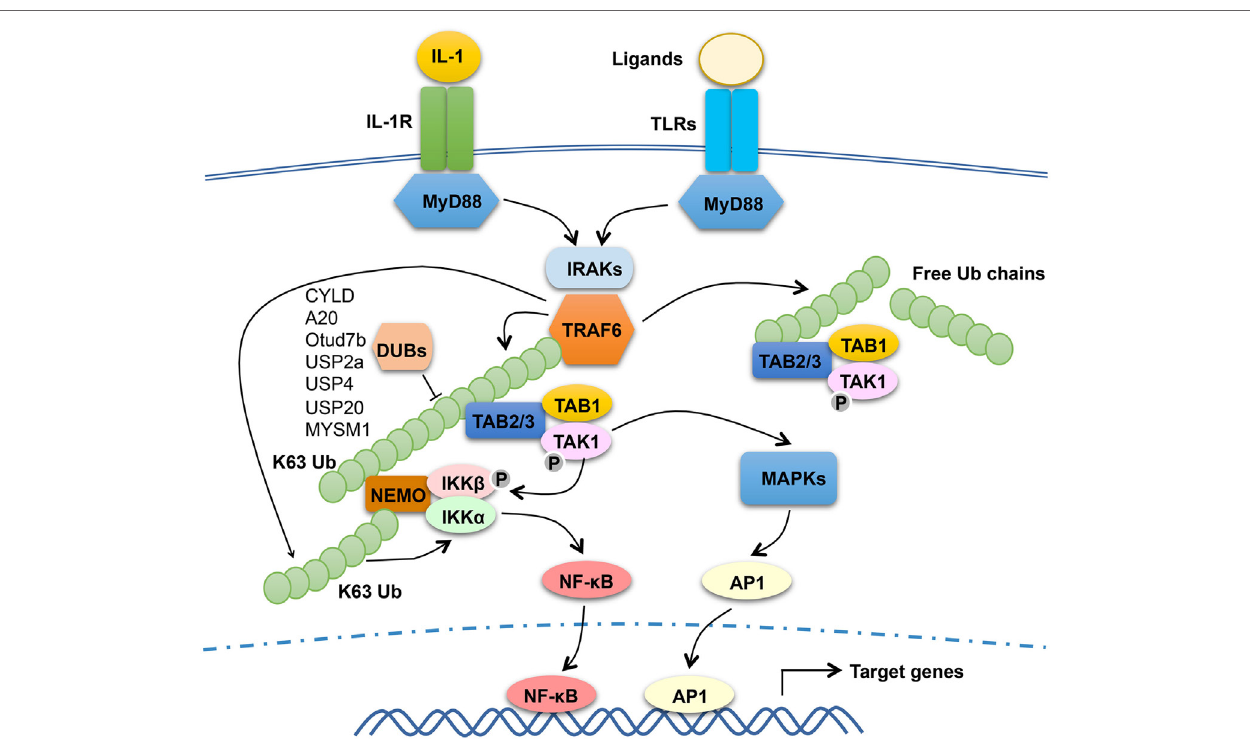
FigURe 1 | The function and regulation of tumor necrosis factor receptor-associated factor (TRAF)6 in MyD88 signaling pathway. Upon stimulation with IL-1 or toll-like receptor (TLR) ligands, MyD88 recruits IL-1R-associated kinases (IRAKs) (including IRAK1, IRAK2, and IRAK4) and TRAF6 to assemble a MyD88 signaling complex. Once activated in the MyD88 complex, TRAF6 functions as an E3 ubiquitin ligase that catalyzes the synthesis of K63-linked polyubiquitin chains conjugated to itself or NF- κ B essential modulator (NEMO) or existing as free ubiquitin chains. The self-ubiquitinated TRAF6 recruits the ubiquitin-dependent kinase transforming growth factor beta-activated kinase 1 (TAK1) and its downstream kinase I κ B kinase (IKK) to assemble a signaling complex that facilitates TAK1 and IKK activation. This process requires the TAK1 regulatory subunit TAB 2 (or TAB 3) and the IKK regulatory subunit NEMO, both have ubiquitin-binding functions. Activated TAK1 mediates activation of IKK and mitogen-activated protein kinases (MAPKs), which further activate nuclear factor κ B (NF- κ B) (RelA- and c-Rel- containing complexes) and AP1. TRAF6 mediated NEMO ubiquitination also contributes to the activation of IKK and NF- κ B. Several DUBs have been shown to negatively regulate TRAF6 function through deconjugation of its K63 polyubiquitin